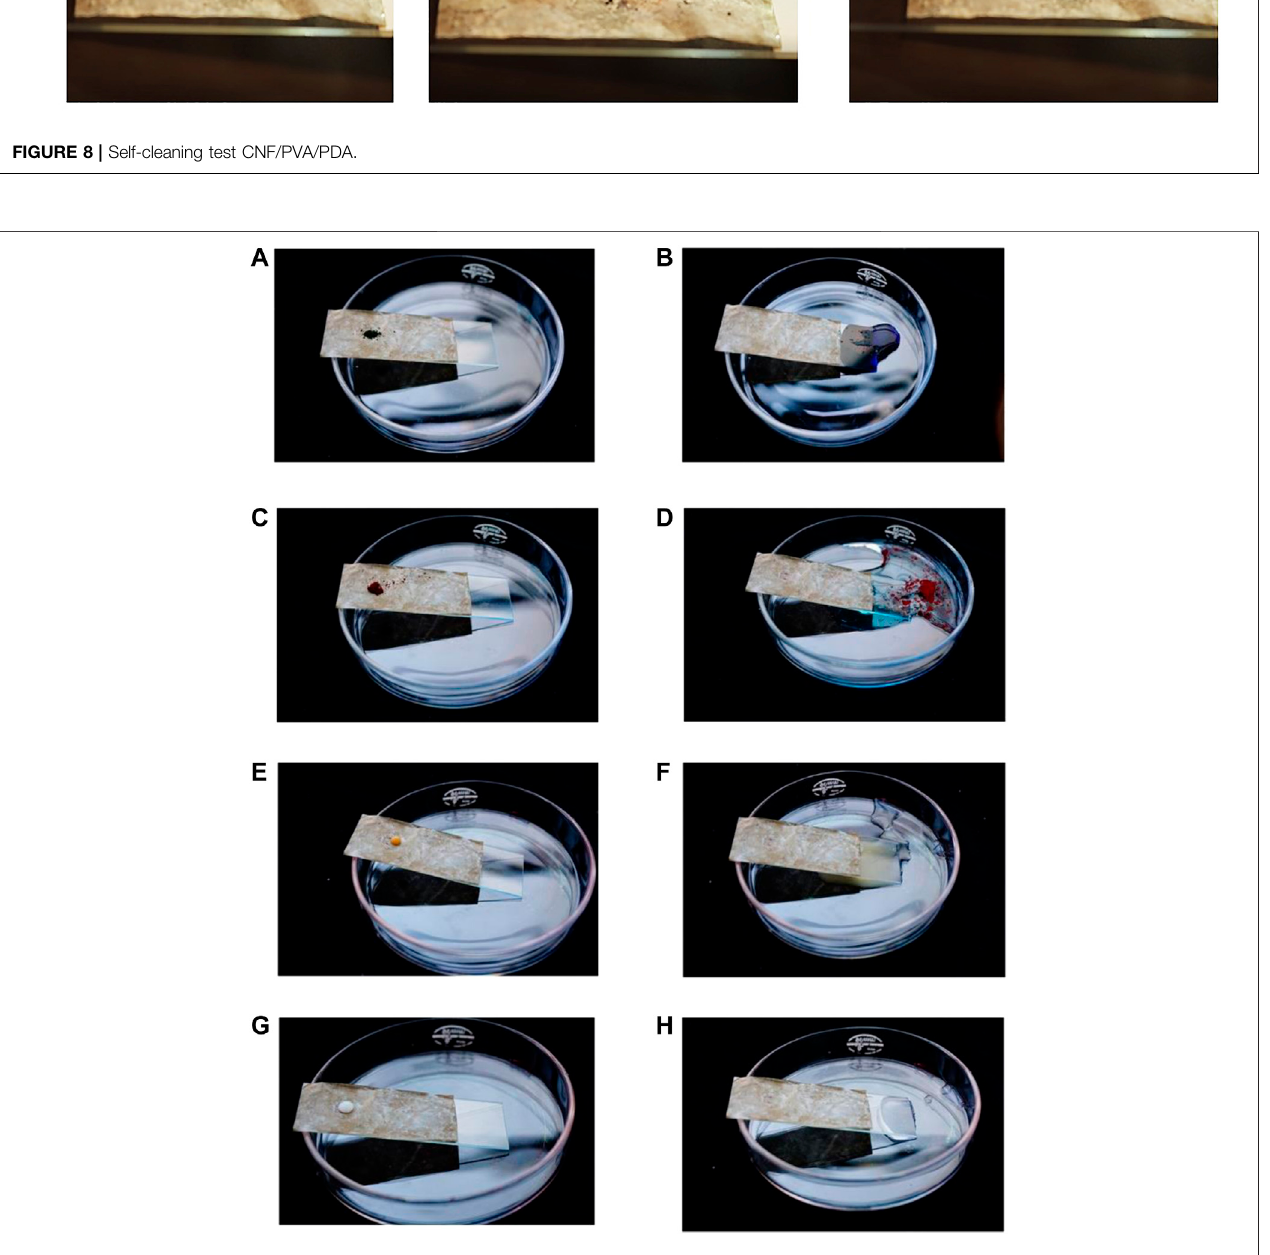
FIGURE 9 | Self-cleaning test CNF/PVA/PDA (A,B) : methylene blue; (C,D) sudan red; (E,F) coffee juice; (G,H) milk juice).